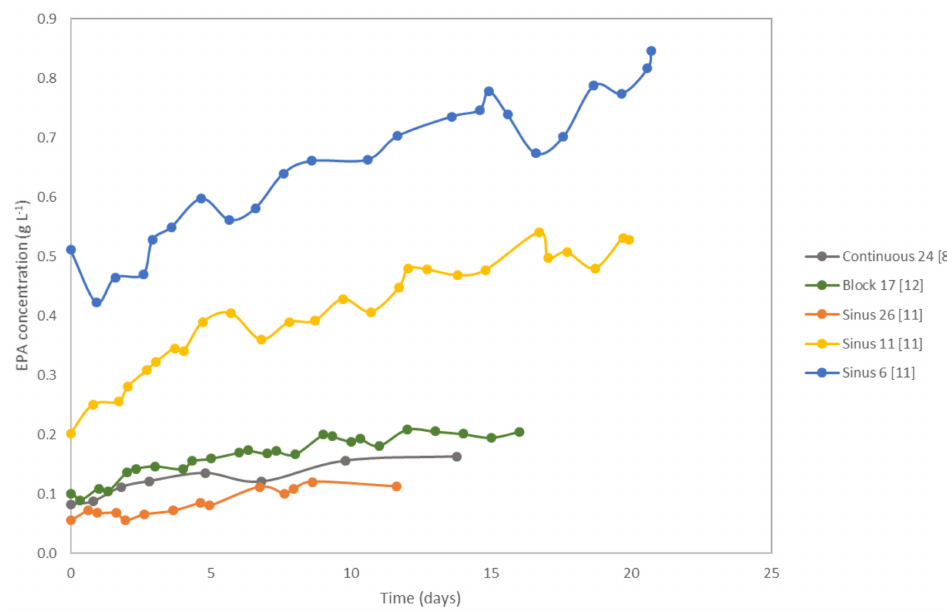
Figure A3. Total EPA concentration (g L − 1 ) measured in the photobioreactor for the different biomass-specific photon supply rates and light regimes from the moment of nitrogen starvation [8,11,12].